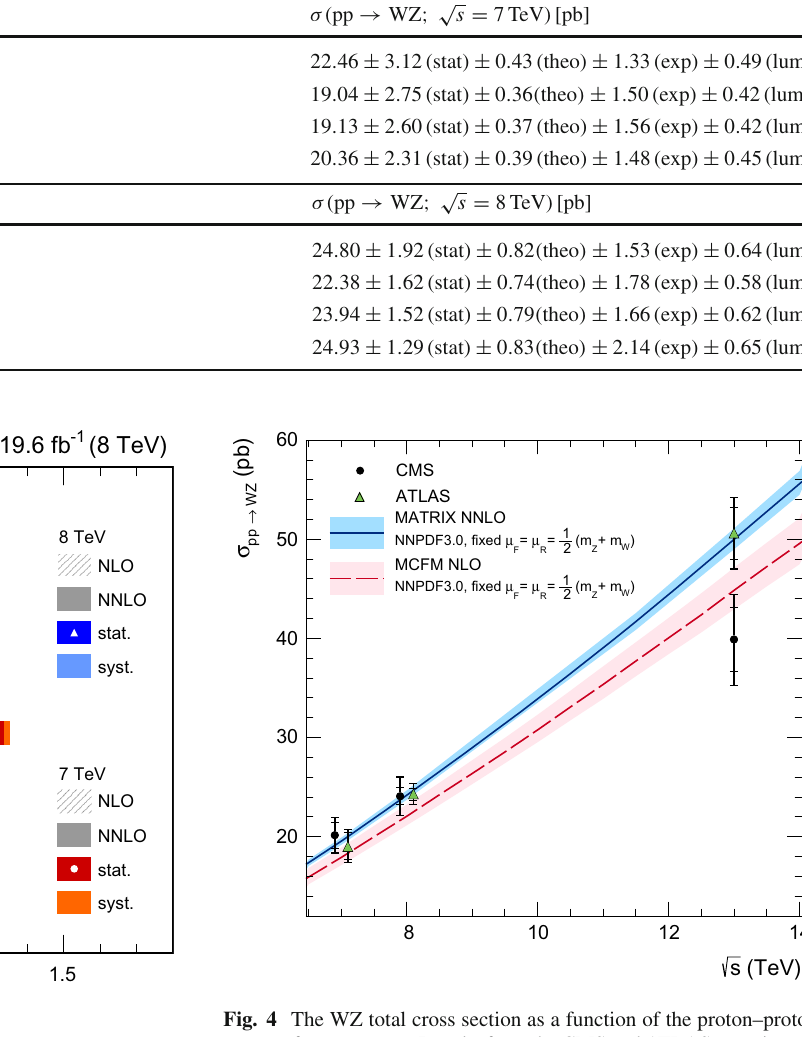
Fig. 3 Ratio of measured inclusive cross sections to NNLO predic- tions. The vertical gray bands represent the theoretical uncertainties at 7 and 8TeV